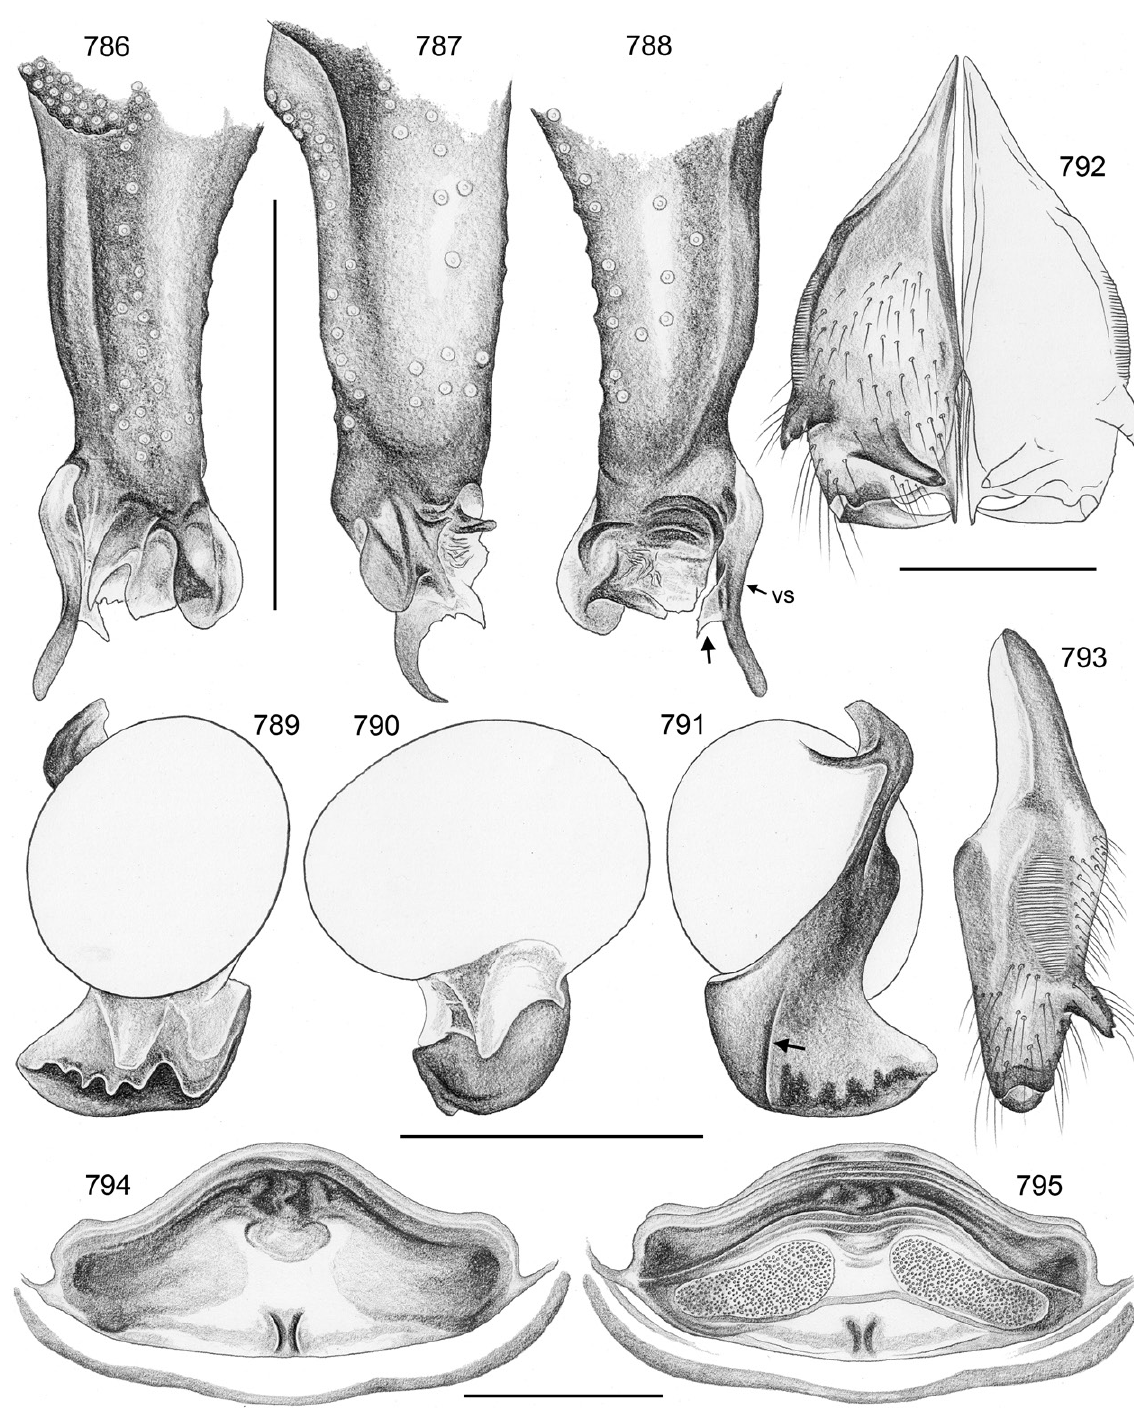
Figs 786–795. Crossopriza lyoni (Blackwall, 1867); male from Guinea, Kindia (ZFMK Ar 10456, see Huber & Kwapong 2013), female from Japan, Yamamoto-chô (ZFMK Ar 5209). 786–788 . Left procursus, prolateral, dorsal, and retrolateral views; arrow: branch of ventral sclerite. 789–791 . Left genital bulb, prolateral, dorsal, and retrolateral views; arrow: retrolateral ridge. 792–793 . Male chelicerae, frontal and lateral views. 794–795 . Cleared female genitalia, ventral and dorsal views. Abbreviation: vs = ventral sclerite. Scale bars = 0.5